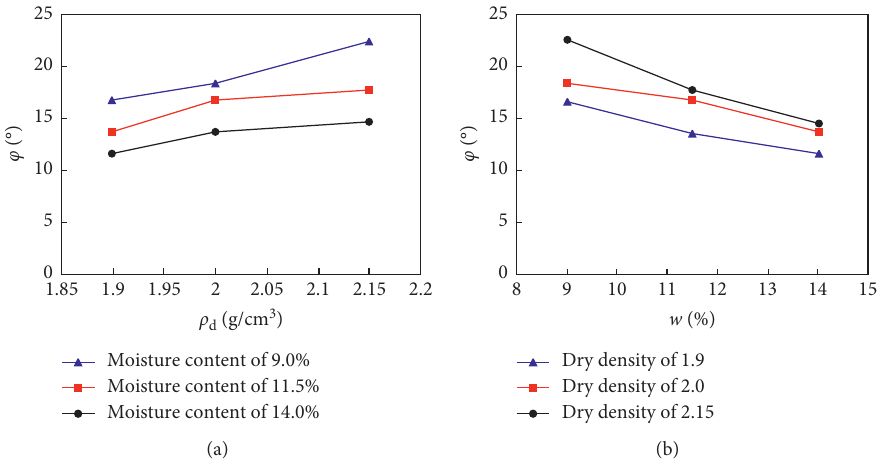
Figure 12: (a) Relationships between internal friction angle ( φ ) and dry density ( ρ and moisture content ( w